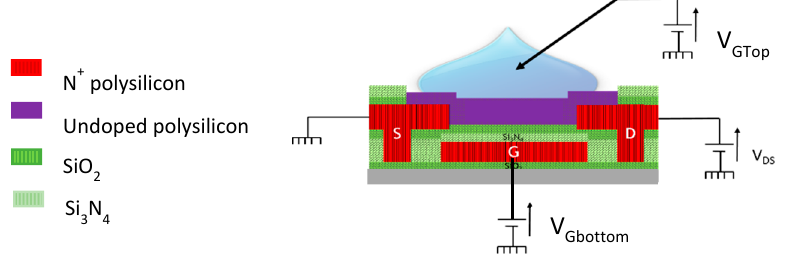
Figure 1. Dual Gate Field Effect Transistor – structure and measurement setup.